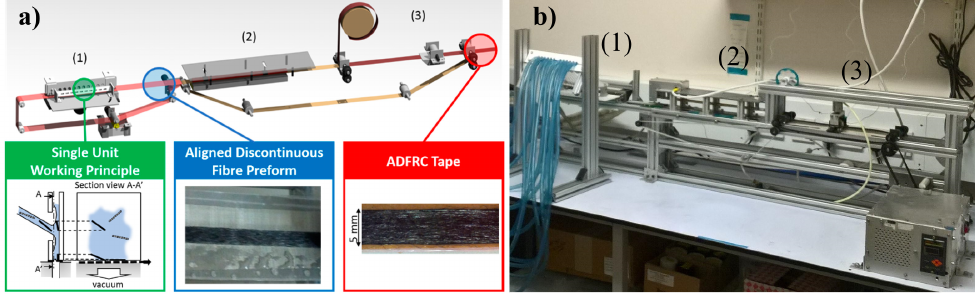
Figure 1. ( a ) The HiPerDiF fibre alignment method principles and dry carbon fibre preform output (stage 2) [23,30], ( b ) an image of the second generation HiPerDiF machine (Bristol Composite Institute, Bristol, UK) highlighted with stages mentioned in Section